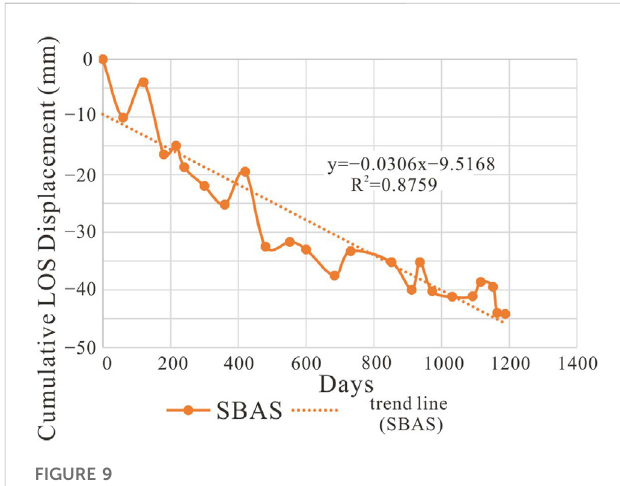
FIGURE 8 Cumulative LOS displacement of zone “ a ” (PSI and SBAS results).